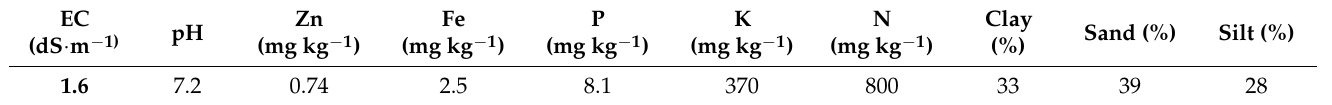
Table 3. Physical and chemical properties of experimental